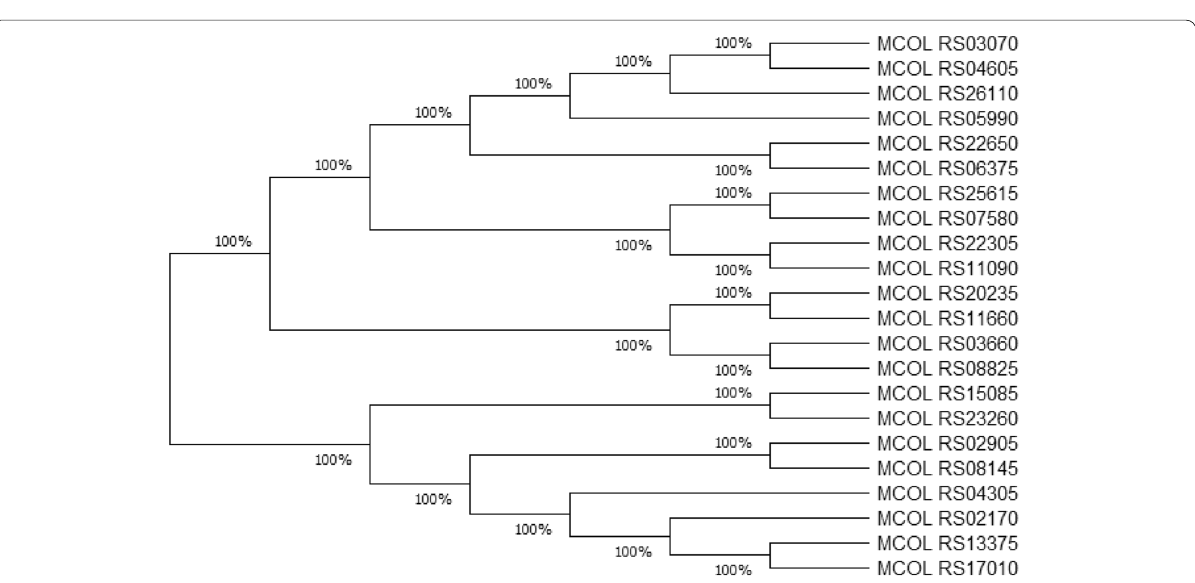
Fig. 3 Phylogenetic tree of M . colombiense CECT 3035 genes using neighbor-joining